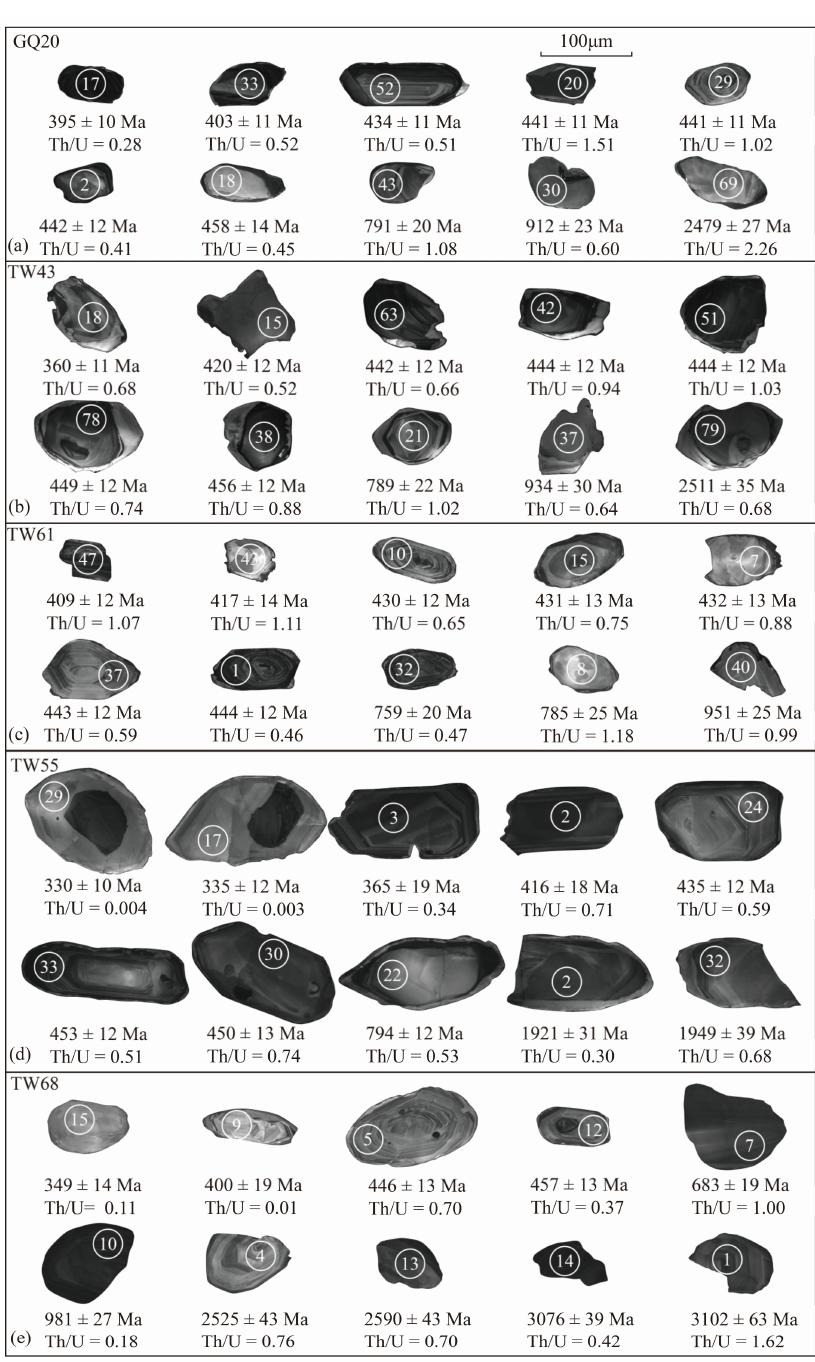
Figure 3. Representative cathodoluminescence images of zircons from the Wuguan Complex and Liuling Group. ( a ) The majority of zircons from sample GQ20 with clear oscillatory zoning; ( b ) Zircons from sample TW43 with a magmatic, oscillatory zoned core and a thin, brightly luminescent rim; ( c ) Zircons from sample TW61 with a oscillatory or planar zoned core and a thin, brightly luminescent rim; ( d ) Zircons from sample TW55 with dark and exhibited oscillatory zoning or straight, banded patterns; ( e ) Zircons from sample TW68 with cores exhibited oscillatory or planar